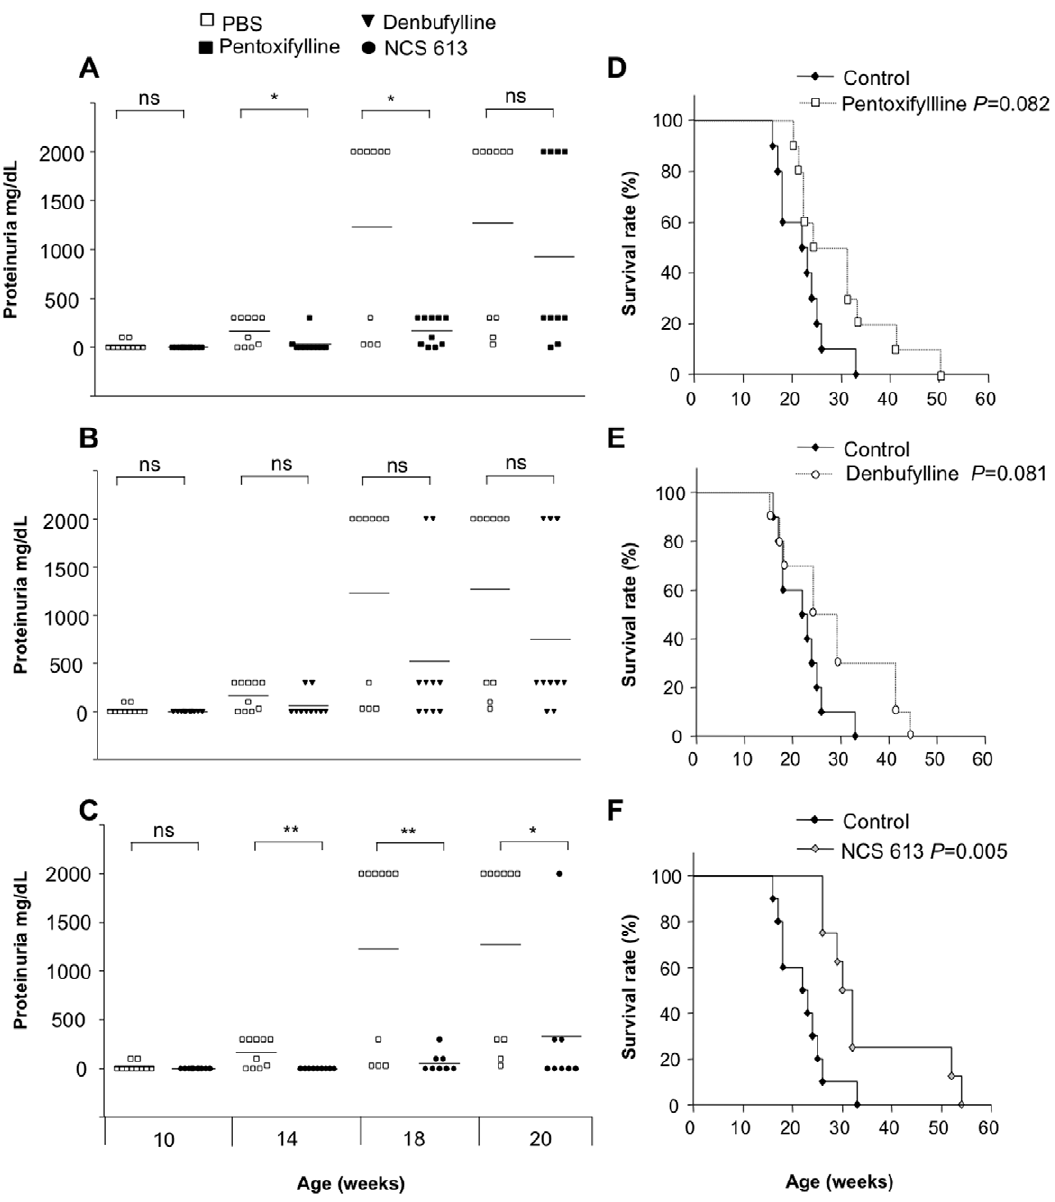
Figure 5. Pentoxifylline, denbufylline and NCS 613 treatment effects on proteinuria and survival rate of MRL/lpr mice. Four groups of MRL/lpr mice were injected via the i.v. route at 5, 7, 9 and 13 weeks with either 100 m L of PBS-10% ethanol (control, n=10), or 100 m g pentoxifylline in 100 m L PBS-10% ethanol (n=10), or 100 m g denbufylline in 100 m L PBS-10% ethanol (n=10), or 30 m g NCS 613 in 100 m L PBS-10% ethanol (n=8). Proteinuria was measured as described in the Methods section at weeks 10, 14, 18 and 20 are represented for each mouse. Each symbol represents an individual mouse and horizontal lines indicate the median. Closed symbols represent PBS-treated mice and open symbols represent inhibitors-treated mice (pentoxifylline, denbufylline and NCS 613). Because PBS-treated-MRL/lpr mice present a high mortality, dead mice were considered to have a proteinuria . 2000 mg/dL (the level measured the week before their death). Survival rate is expressed as the percentage of surviving mice with time expressed in weeks. *, P , 0.05; **, P , 0.01, ns; not significant.